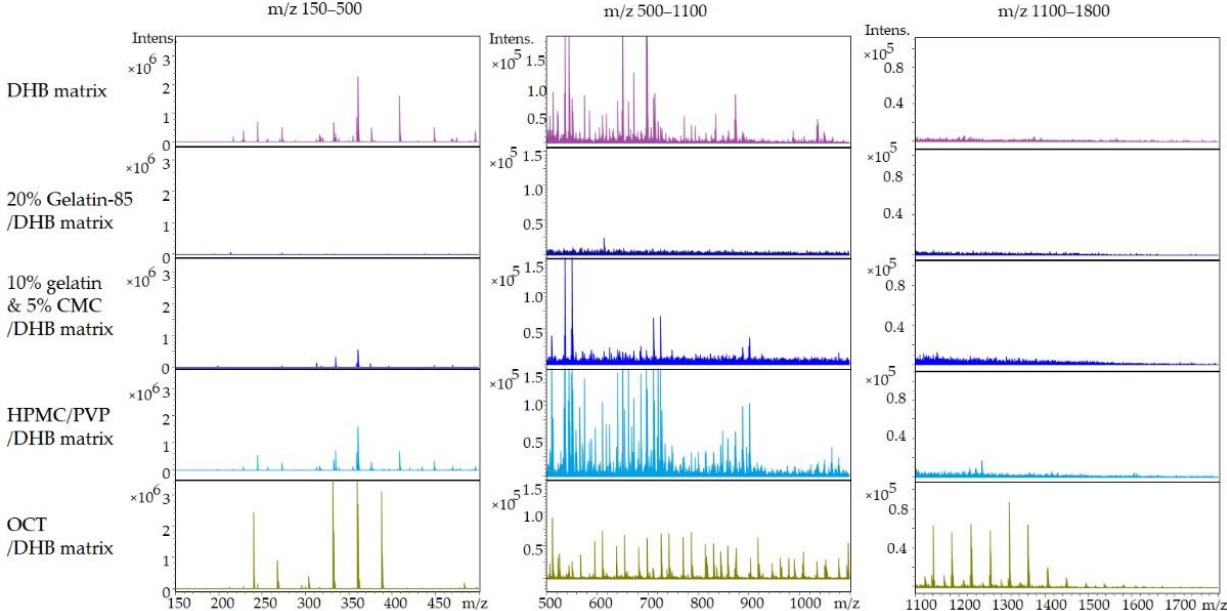
Figure 1. Comparison of the mass spectra of different embedding media under MALDI conditions with DHB matrix coating at three m / z windows: m / z 150 – 500; m / z 500 – 1100; m / z 1100 – 1800 .